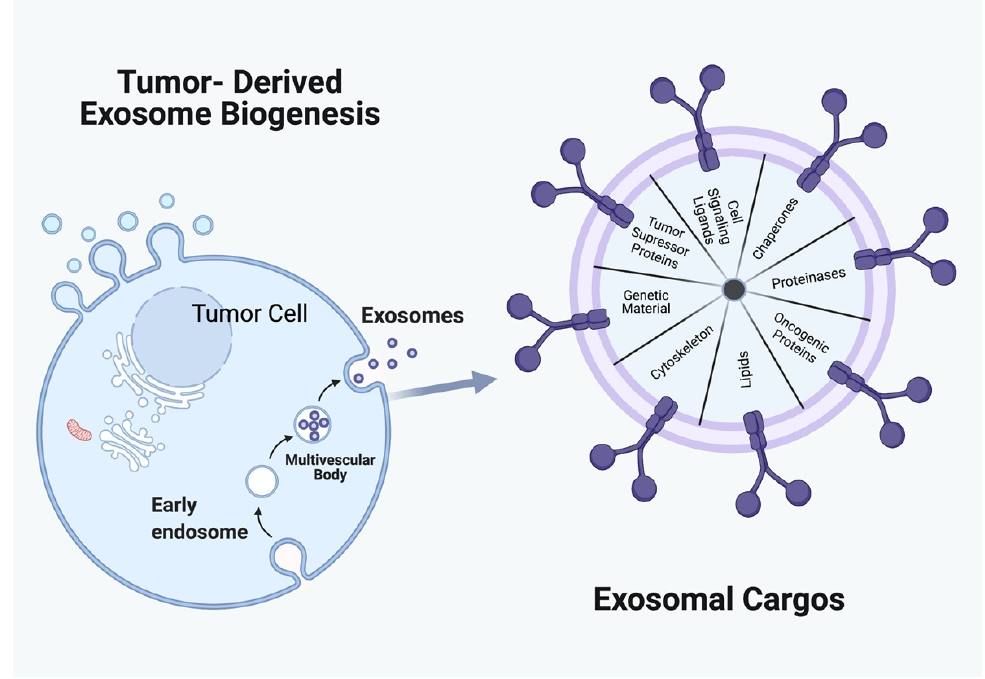
Figure 1. Tumor-derived exosome biogenesis and cargo. Created with BioRender.com (accessed on 17 December 2021).